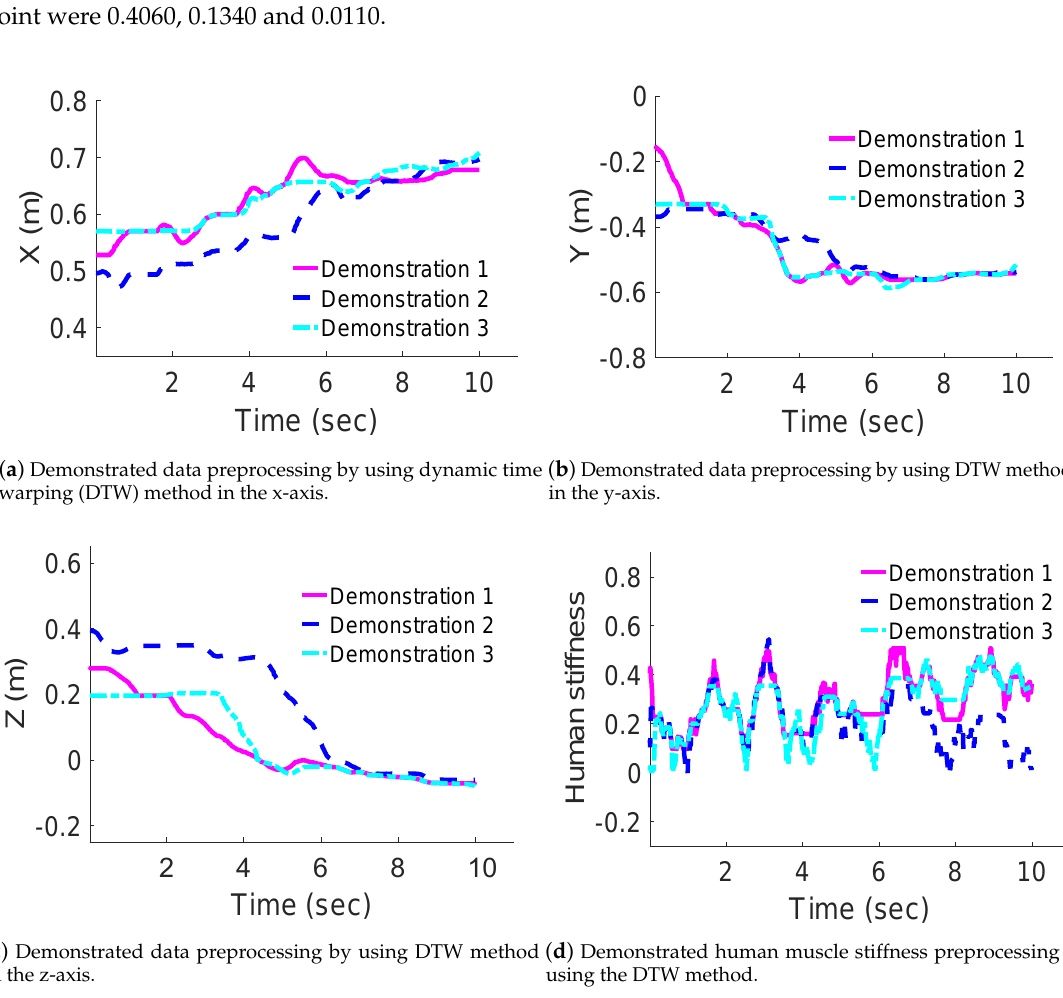
Figure 8. Preprocessing of demonstrated observations by the DTW